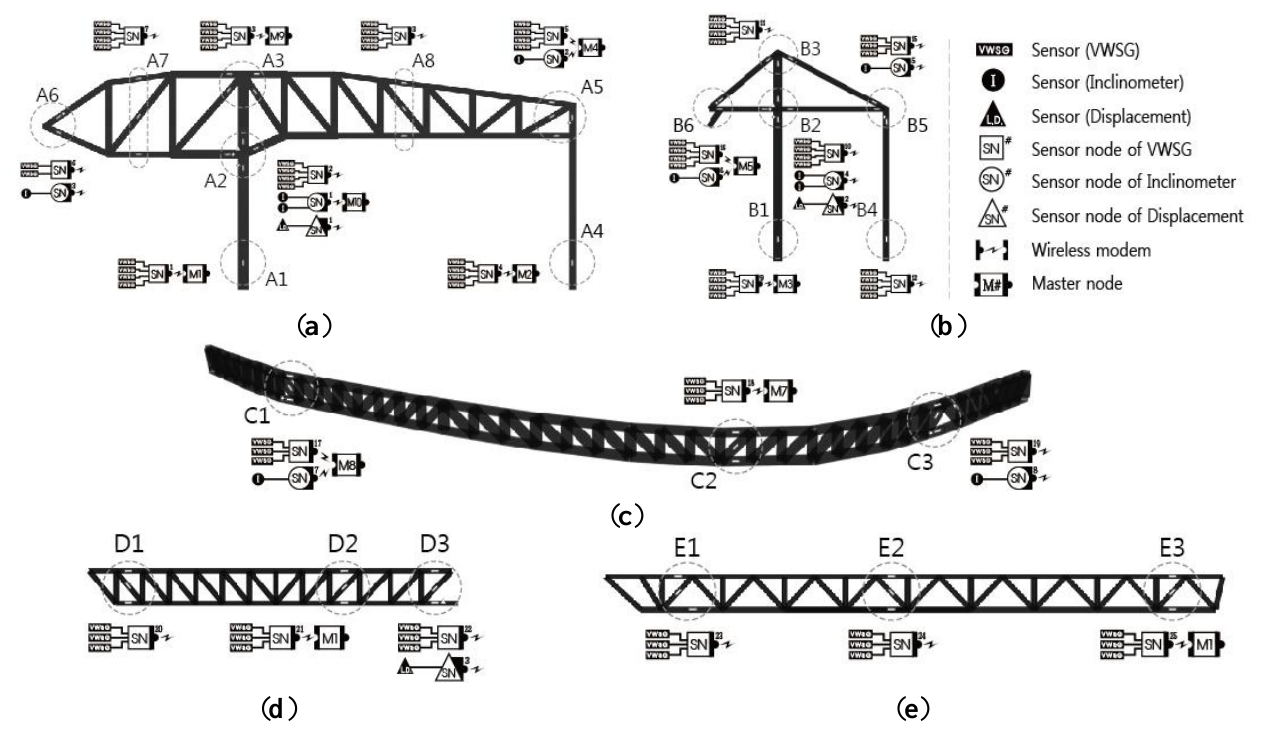
Figure 8. Sensing location for the monitoring zones at DPB. ( a ) A zone; ( b ) B zone;